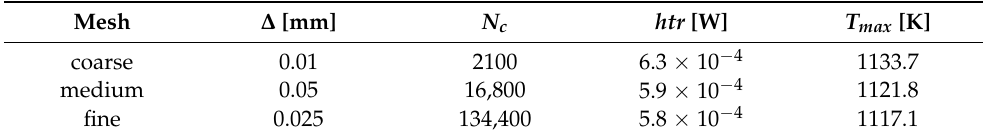
Figure 5. Computational meshes for sensitivity study: ( a ) coarse; ( b ) medium; ( c ) fine. Table 4. Sensitivity study parameters listing the cell size ∆ , the number of cells N c , the total heat transfer rate htr and the maximum temperature T max of the MLL (WC/SiC).